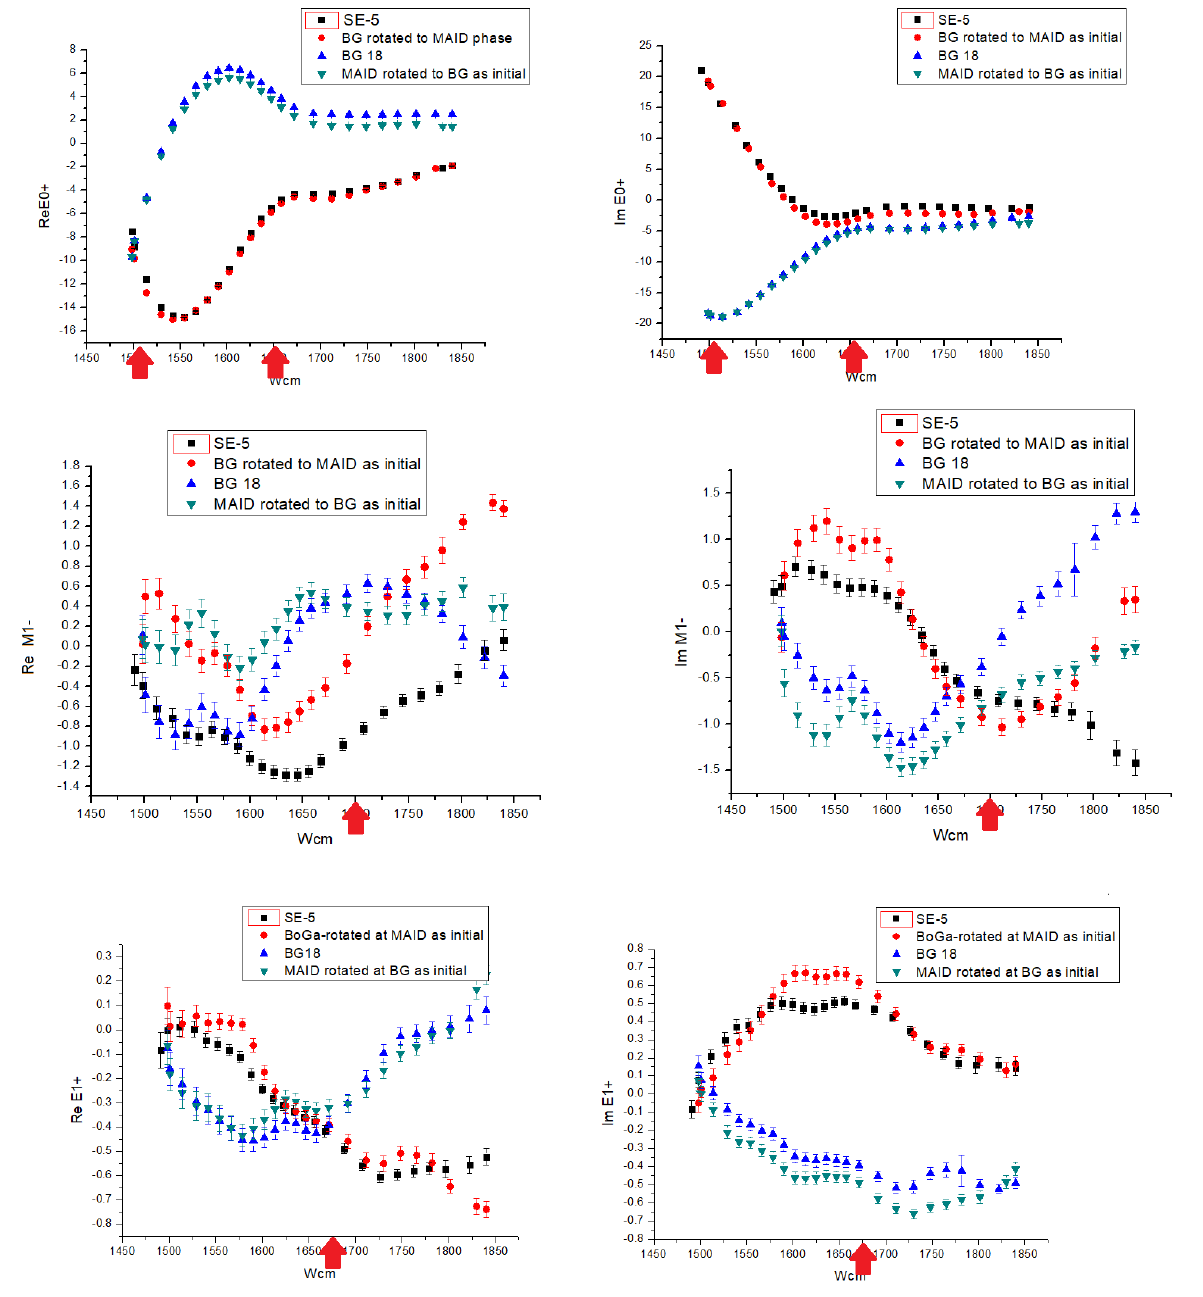
Figure 5: (Color online) Final set of η -photoproduction partial wave amplitudes obtained in ref. [2] for the lowest multi-